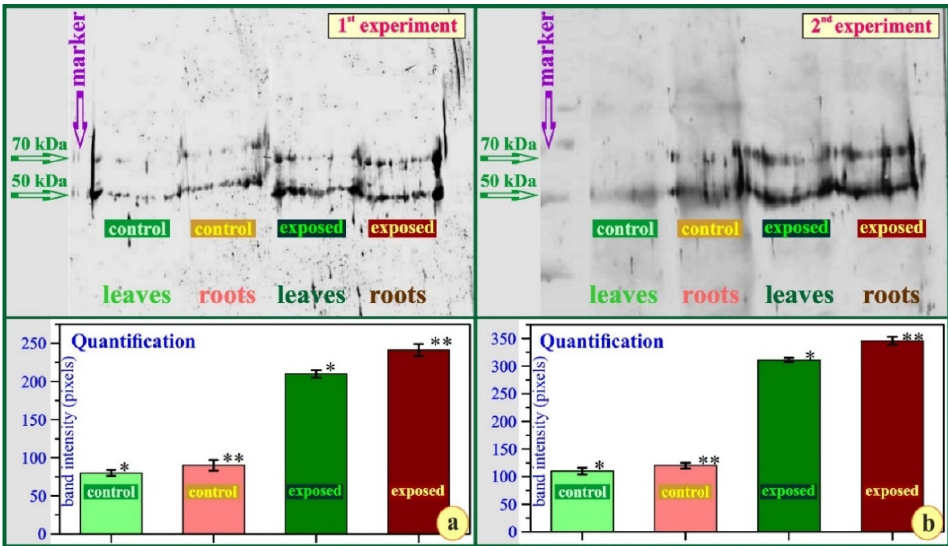
Figure 5. Immunodetection of L-Dopa DeCaboxylase (DDC) in leaf samples of “control” and “exposed” plants of C. creticus using the polyclonal specific anti-human DDC C-terminal antibody. Error bars represent the standard error of the mean (SEM). Subfigures (a) and (b) depict the quantification of the lower bands of each sample is provided through the graphs. Differences were considered as statistically significant when p < 0.05. Asterisks indicate statistically significant differences: * comparison between control and exposed leaves, and ** between control and exposed roots.